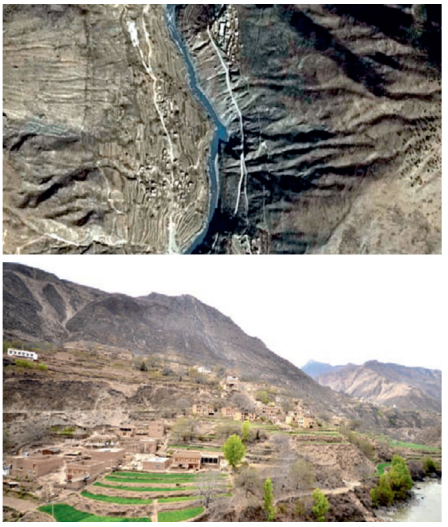
Fig. 2. Yuejin Village, Dongwang